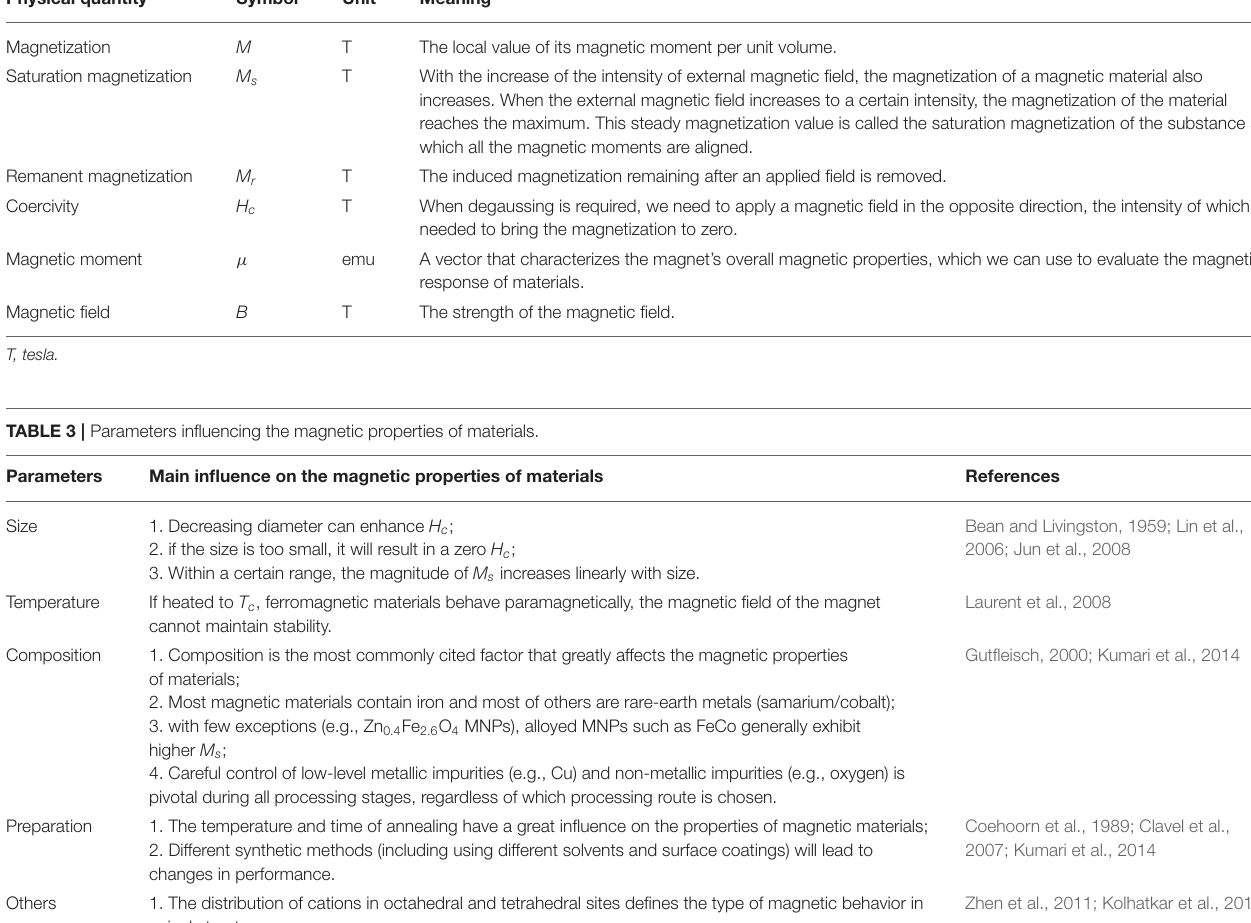
TABLE 2 | Several main physical quantities used to describe the magnetic properties of materials (Bozorth, 1947). Physical quantity Symbol Unit